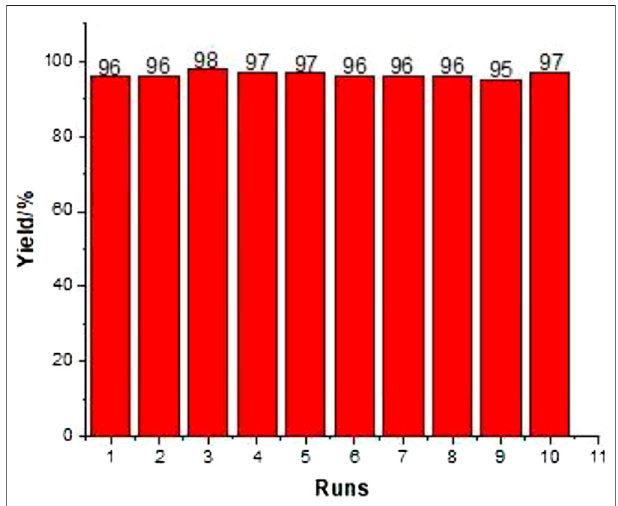
FIGURE 5 | Recyclability of 3D SiO 2 -NH-SO 3 H.